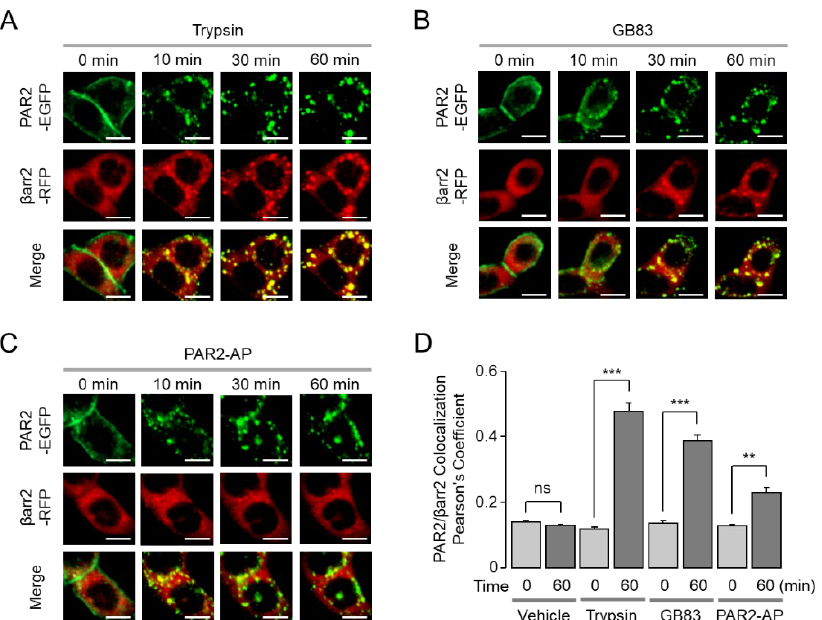
Figure 7. GB83 induces sustained colocalization of PAR2 and β -arrestin2. ( A – C ) Effect of trypsin, GB83, and PAR2-AP on the localization of PAR2 and β -arrestin2 ( β arr2) in HT-29 cells expressing EGFP-tagged PAR2 and RFP-tagged β -arrestin2. Cells were treated with trypsin (30 U/mL), GB83 (30 µM), PAR2-AP (30 µM), and the cellular localization of PAR2 (green) and β -arrestin2 (red) were observed at 0, 10, 30, and 60 min after treatment of each agonist. ( D ) Quantitative analysis of colocalization of PAR2 and β -arrestin2 (mean ± S.E., n = 5). Colocalization values were calculated in Pearson’s correlation coefficient using the colocalization plugin JACoP. Statistical significance of differences between indicated groups was assessed by one-way ANOVA with Tukey’s post-hoc